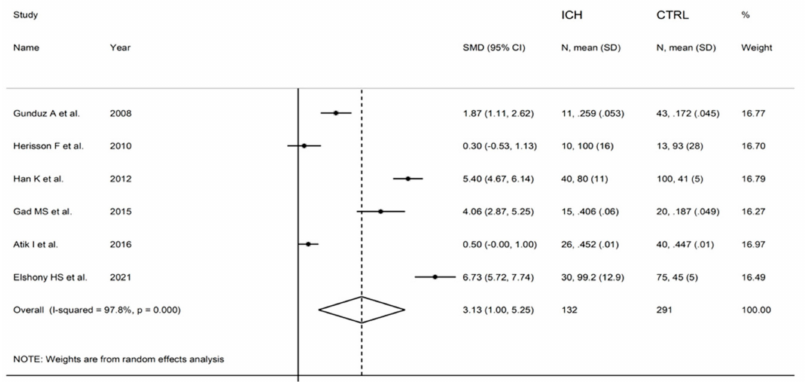
Figure 8. Forest plot of studies examining ischaemia-modified albumin in patients with intracerebral haemorrhage and controls.